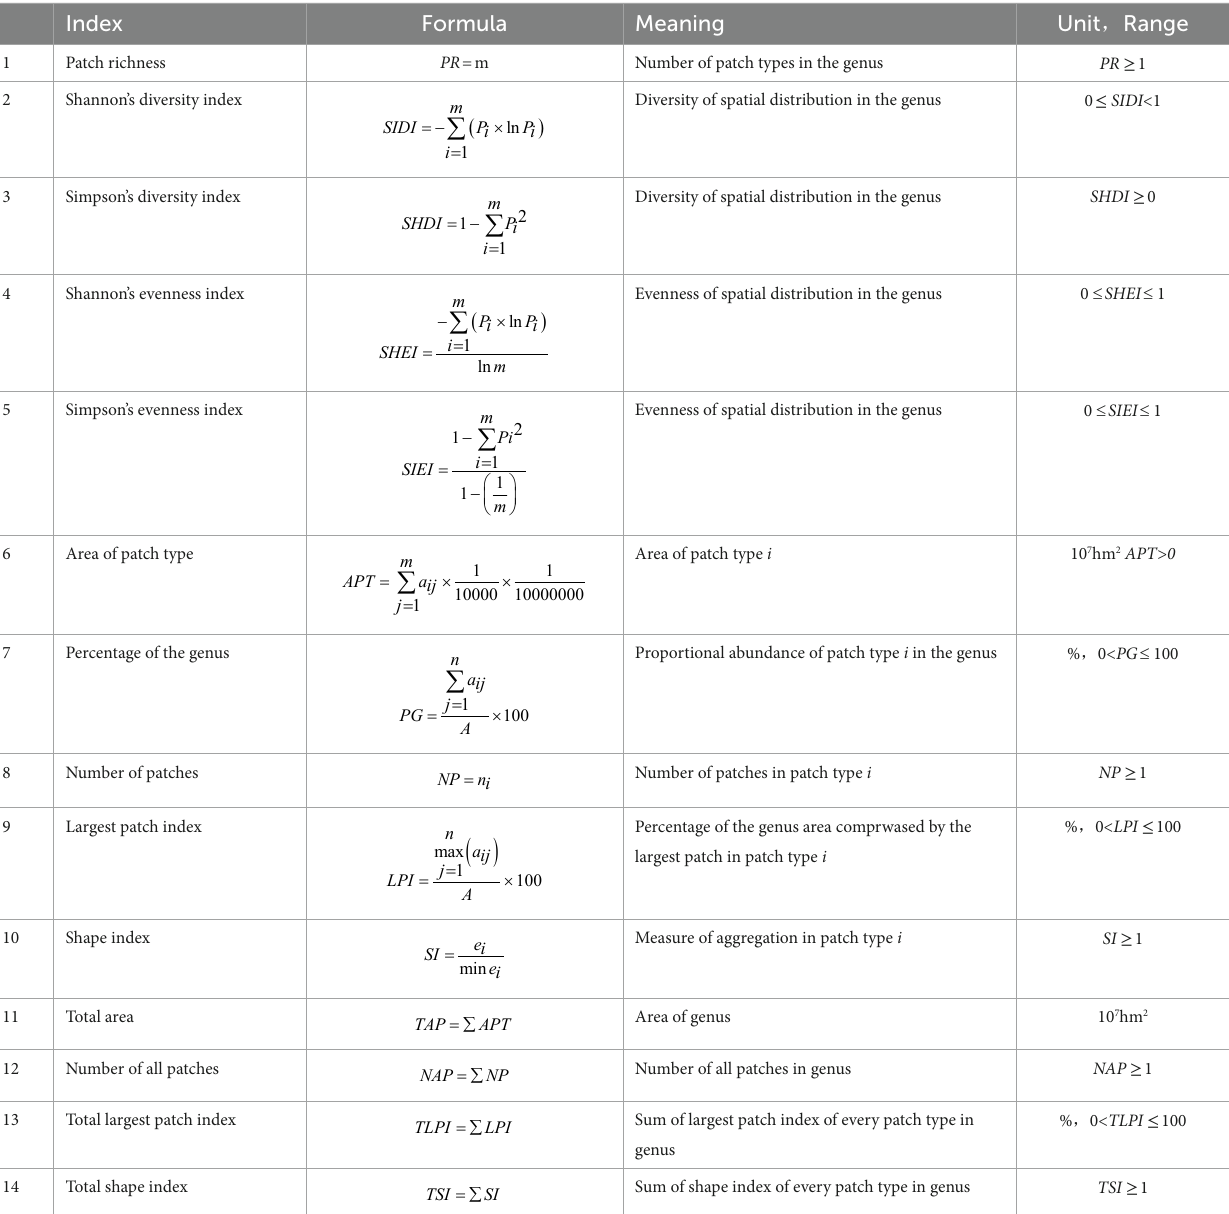
TABLE 1 Indices of spatial diversity